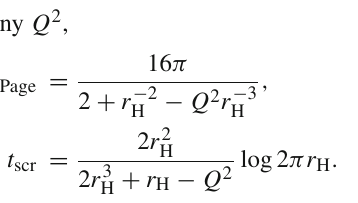
Fig. 10 Page curve for the critical temperature. The large and small black holes coexist any Q 2 , Fig. 11 Page curves as a function of time t and radius r H at Q